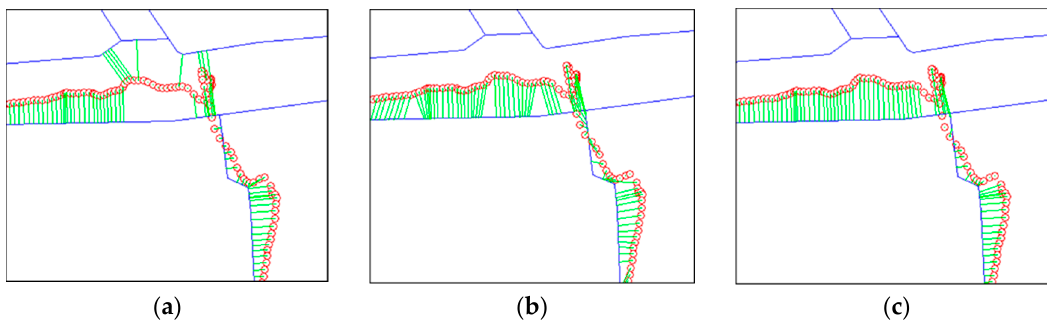
Figure 16. Comparison of results from ( a ) conventional method, ( b ) basic Fréchet-distance-based method, and ( c ) adaptive Fréchet-distance-based method applied to Trajectory 4. Thick lines are PND segments and circles are GPS-recorded points. Lines connecting points and PND segments are the reference matches of the ground truth dataset. Applying the Fréchet-distance-based method reduced the error and increased the number of correct matches.